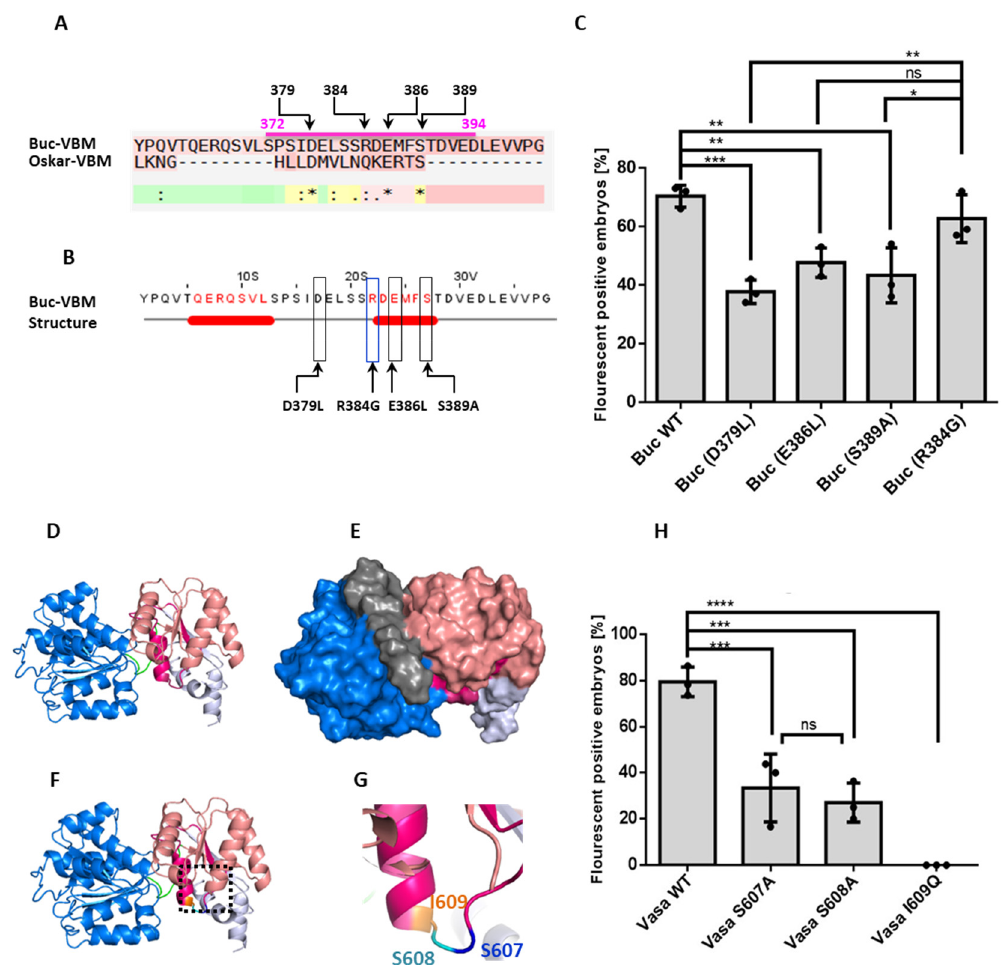
Figure 4. Isolation of the amino acid residues responsible for Buc and zfVasa interactions. ( A ) Alignment of the Buc-VBM with the Oskar eLOTUS domain. An asterisk (*) denotes the positions with a fully conserved residue. A colon (:) denotes conservation based on strongly similar properties—scoring > 0.5 in the PAM 250 matrix. A dot (.) denotes conservation based on weakly similar properties—scoring ≤ 0.5 in the PAM 250 matrix. An alignment of Buc-VBM and the eLOTUS domain revealed that D379, E384, and S386 are conserved between two sequences (black stars and positions of the amino acids are labeled on top of the sequence). ( B ) Representation of the three amino acids D379, E386, and S389 in JPred secondary structure prediction (black boxes) and amino acid R384 (blue box) used as a non-conserved control. ( C ) Quantification of mutant Buc construct interactions with zfVasa. The Y-axis represents the average fluorescent positive embryos. The X-axis represents the injected mutant Buc constructs. All the mutants, Buc D379L (36 ± 5.1%, n = 86), E386L (48 ± 9.4%, n = 77), and S389A (43 ± 3.4%, n = 50), showed a reduction of fluorescent embryos compared to wild-type Buc (70 ± 4.6%, n = 69) or in the control R384G (63 ± 8.2%, n = 63). In particular, the D379L mutant variant showed the weakest activity when compared to the Buc wild-type and control R384G. ( D ) Homology model predicted for zfVasa with the RecA-like N-terminal domain (blue) and RecA-like C-terminal domain (salmon). zfVasa-BBM is colored in magenta. ( E ) Surface representation of the predicted model showing the exposed region of zfVasa-BBM (magenta). ( F ) Model highlighting the exposed three amino acids (inset in the black dashed line) in the rainbow colors described in ( D ). ( G ) Magnification of the exposed amino acids S607 (blue), S608 (green), and I609 (orange). ( H ) Quantification of the mutant zfVasa construct interactions with Buc. The Y-axis represents fluorescent embryos from three independent experiments. The X-axis represents the injected mutant zfVasa constructs. zfVasa S607A (38 ± 14.0, n =61) and zfVasa S608A (27 ± 8.0, n = 33) showed a reduced number of fluorescence-positive embryos, whereas zfVasa I609Q completely lost the interaction (0 ± 0, n = 61) compared to the wild-type zfVasa (79 ± 6.4, n = 64). Moreover, there was no significant statistical difference observed between zfVasa S607A and S608A. Test statistics: Student’s t -test, * =0.05, ** = 0.01, *** = 0.001, and **** = 0.0001. ns = not significant. To study a putative functional role of these three amino acids during the interaction of Buc with zfVasa, we attempted to create a point in the mutations incl. D379L (aspartate to leucine), E386L (glutamate to leucine), and S389A (serine to alanine) in full-length Buc.